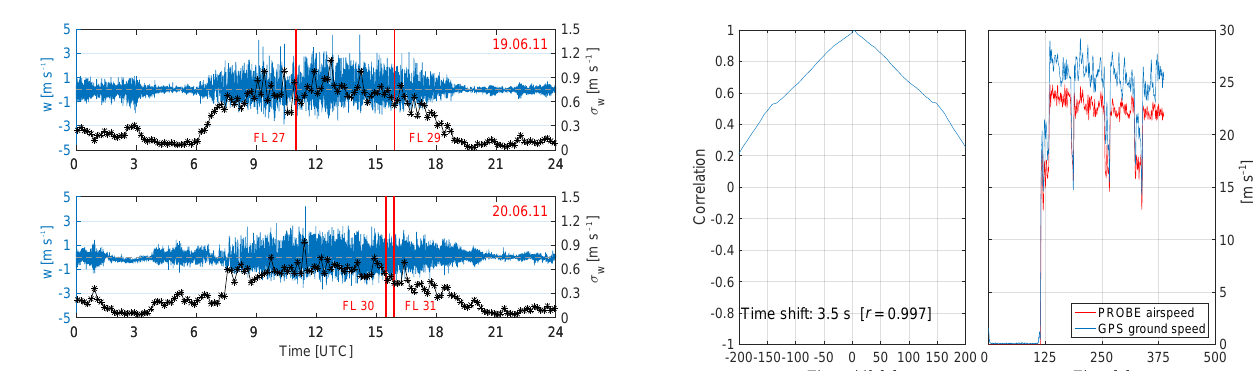
Figure 4. Sonic anemometer measurements (10Hz) of vertical ve- locity, w (blue), and 10min running mean standard deviation of ver- tical velocity, σ w (black), from the 60m meteorological tower for 19 June (top) and 20 June (bottom). The timing of the SUMO flight missions (no. 27, 29, 30 and 31) is indicated by the red lines.